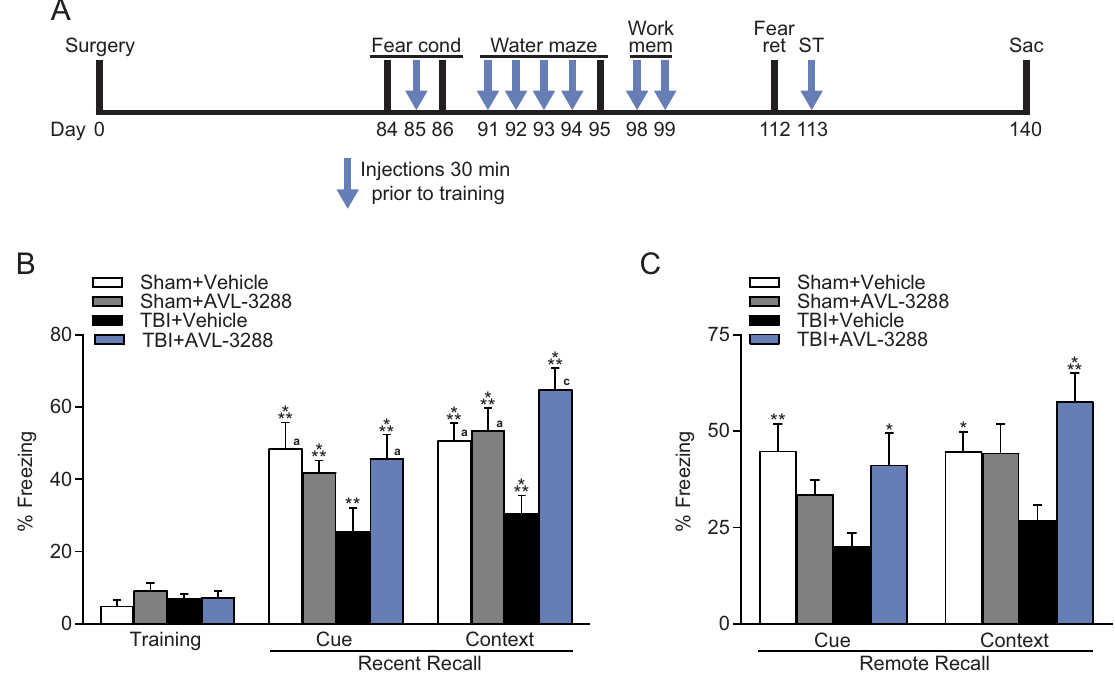
Fig 2. Fear conditioning. Cue and contextual fear conditioning were improved with AVL-3288 treatment in TBI animals. A) Time course of AVL-3288 treatment ( arrows ) and behavioral analyses. Animals were serially tested on fear conditioning and then on the water maze tasks. Animals received AVL-3288 or vehicle treatment 30 min prior to training for fear conditioning (Fear cond), on the 4 training days of the water maze, on each day of training for working memory (Work mem), and during shock threshold testing (ST) for a total of 8 treatments over the course of 1 month as depicted by the arrows . Animals were tested without AVL-3288 treatment for memory retention of fear conditioning at 24 hr and 1 month post-training (Fear ret) and on the probe trial for the water maze at 24 hr post-training. B) Recent recall of fear conditioning at 24 hr after training. �� p < 0.01, ��� p < 0.001 vs. Training, a p < 0.05, c p < 0.001 vs. TBI+Vehicle, repeated measures two-way ANOVA with Tukey’s HSD post-hoc test. C) Assessment of fear conditioning at one month after training to